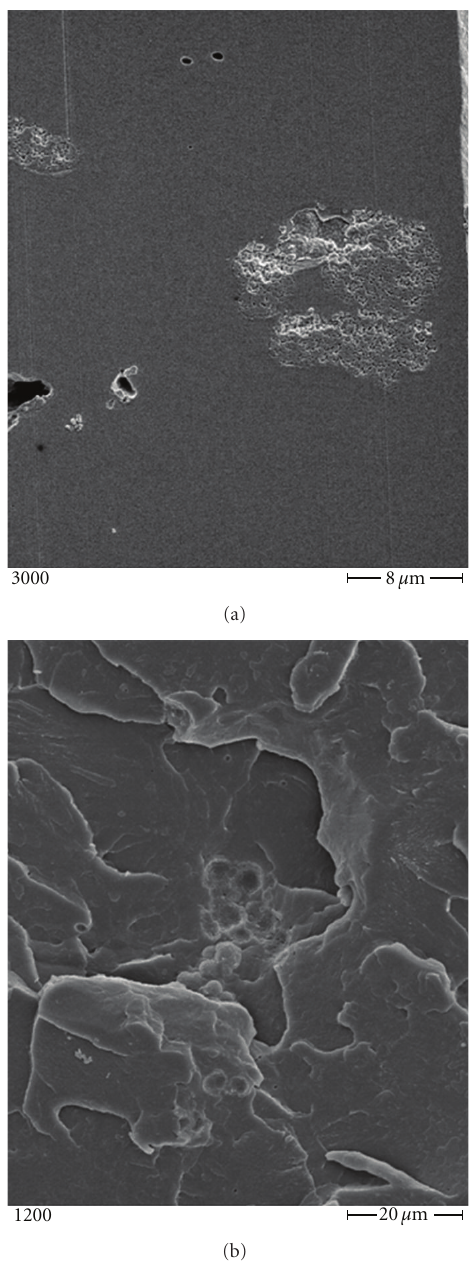
Figure 2: Scanning electron microscopy: daptomycin-laden PMMA at magnifications of (a) 3000 and (b)